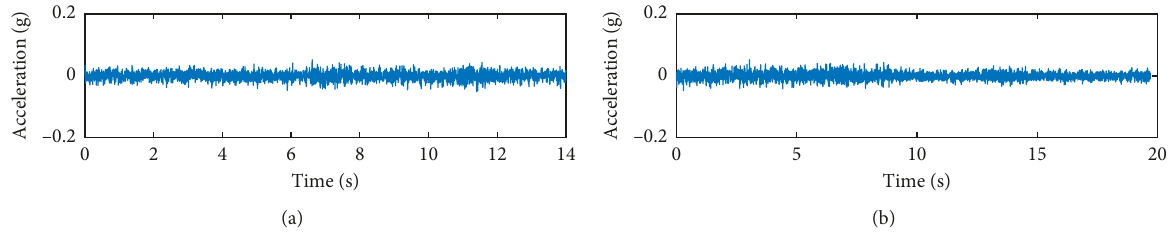
Figure 9: Results of SK of the two vibration signals. (a) Experiment 1: B f c 20.8333Hz. (cid:31)